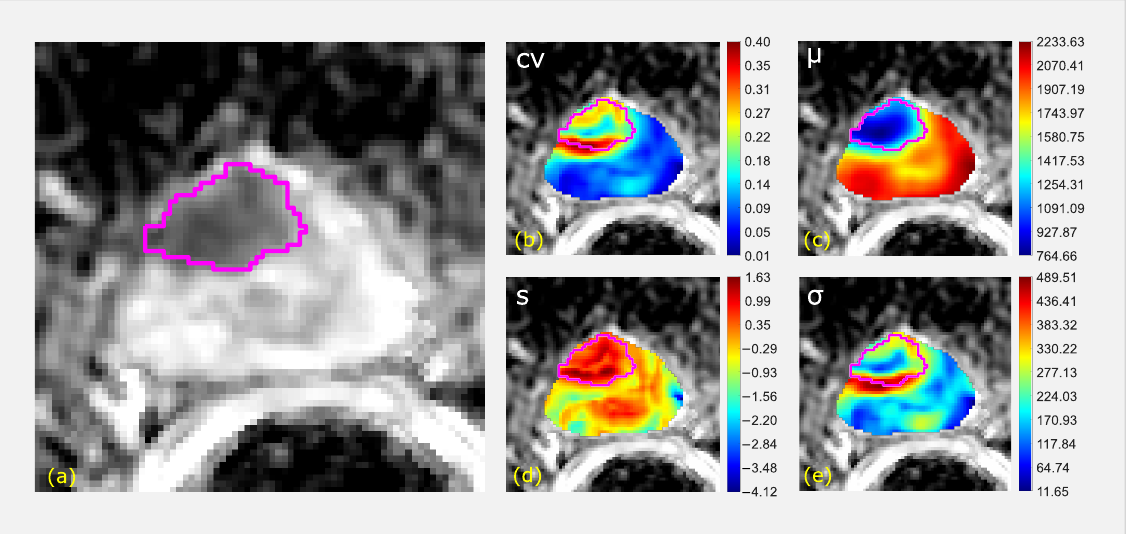
Figure 3. A representative ADC slice ( a ) for a non-csPCa (GG2) and the four colorimetric maps of cv